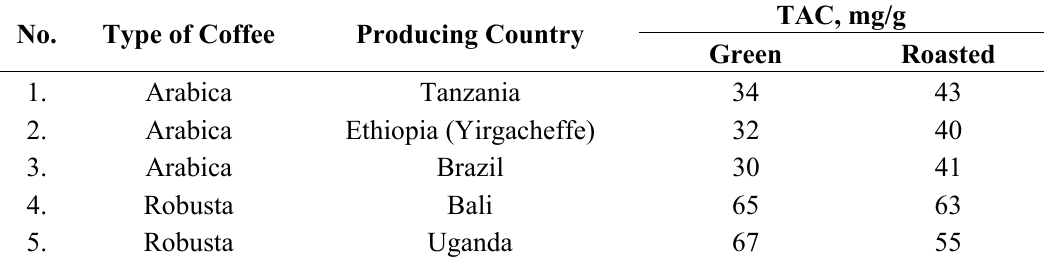
Table 10. Impact of coffee roasting process on the total antioxidant content (quercetin used as standard)